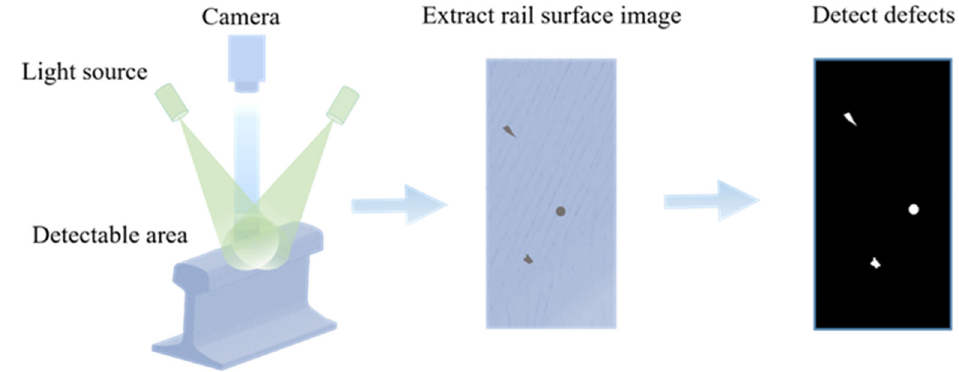
Figure 6. An auxiliary vision system based on a light source. Table 6. Comparison of visual inspection methods.